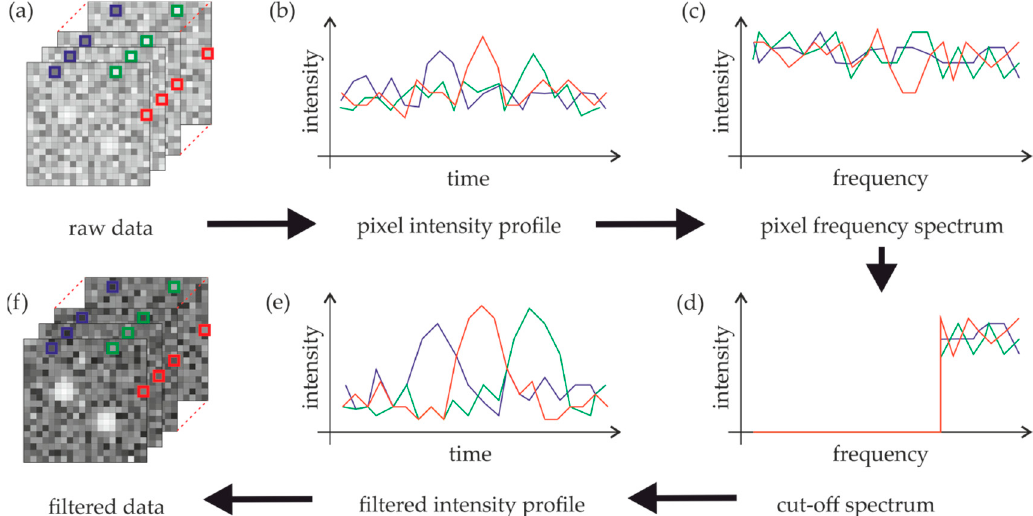
Figure 2. The procedure of temporal filtering. The image sequence containing faint single molecule signals is analyzed on a pixel-by-pixel basis ( a ), yielding the time course of the intensity for each pixel ( b ). We use a fast Fourier transformation (FFT) to obtain the respective frequency spectrum per pixel ( c ). After applying a high-pass filter with a threshold frequency ω T ( d ), an inverse FFT is used to transform the filtered frequency spectra back to time-space ( e ), yielding the final temporal filtered images ( f ).